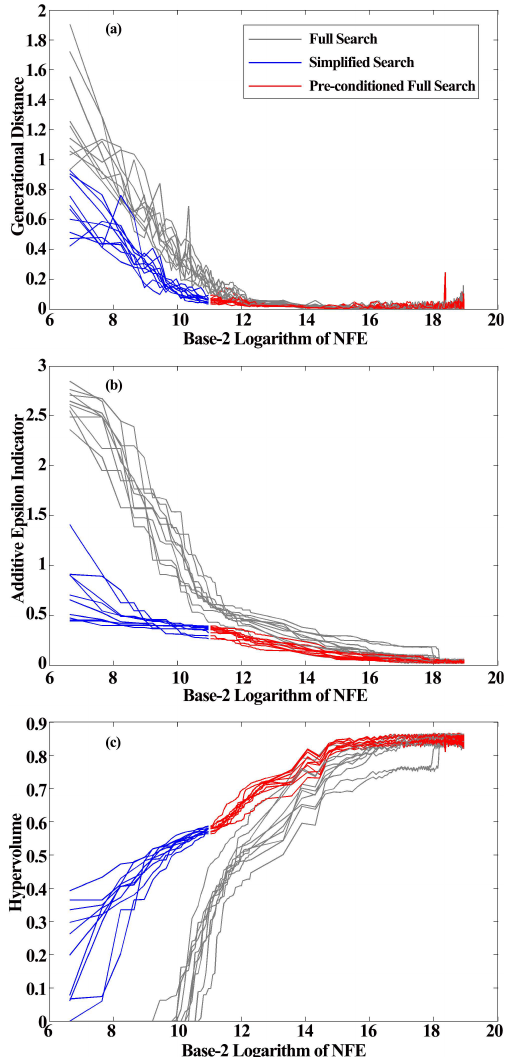
Figure 5. Performance metrics for the Dahuofang ROS problem – (a) generational distance, (b) additive epsilon indicator, and (c) hypervolume.